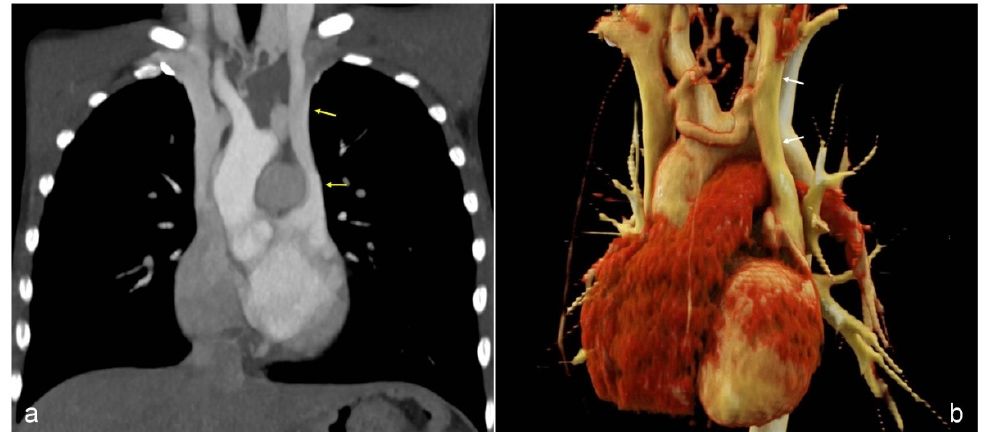
Figure 1. ( a ). Computed tomography reveals a persistent left SVC (arrows) with drainage in the left atrium and resulting right-to-left shunt; right SVC is regularly present, draining to the right atrium.( b ). A3D-volume rendering image of the computed tomography confirms the condition; it allows to better appreciate a bridging vein between left and right SVS, with mean diameter of 7 mm.